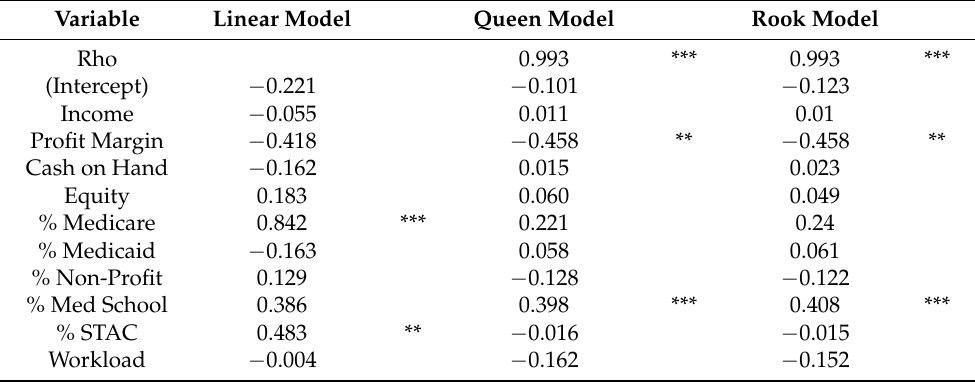
Table 5. Results of the state-level regression.